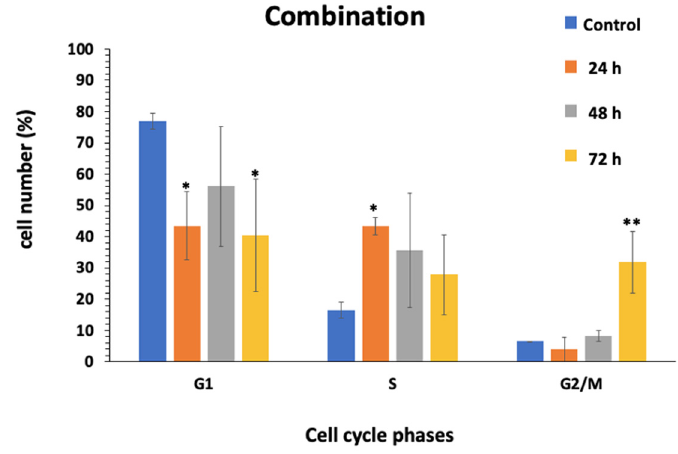
Figure 13. ( A ) DNA histograms of monotherapy and combination therapy on HCT116 cell cycle profile. The first and second peaks represent DNA content in G0/G1 and G2/M phases. Cell number plotted against the intensity of PI. Flow cytometric histograms are representative of 3 separate experiments. ( B ) Cell distribution percentage in each phase of HCT116 cell cycle. Data are presented as mean ± SD of 3 separate experiments, * p < 0.05, ** p < 0.01 indicate significant difference compared to control.